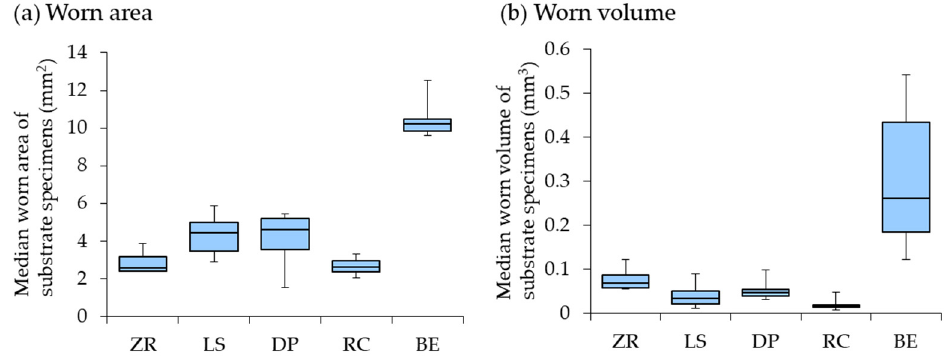
Figure 3. Box plots of worn area ( a ) and volume ( b ) of the substrate specimens. Abbreviations of each experimental group are shown in Table 1.